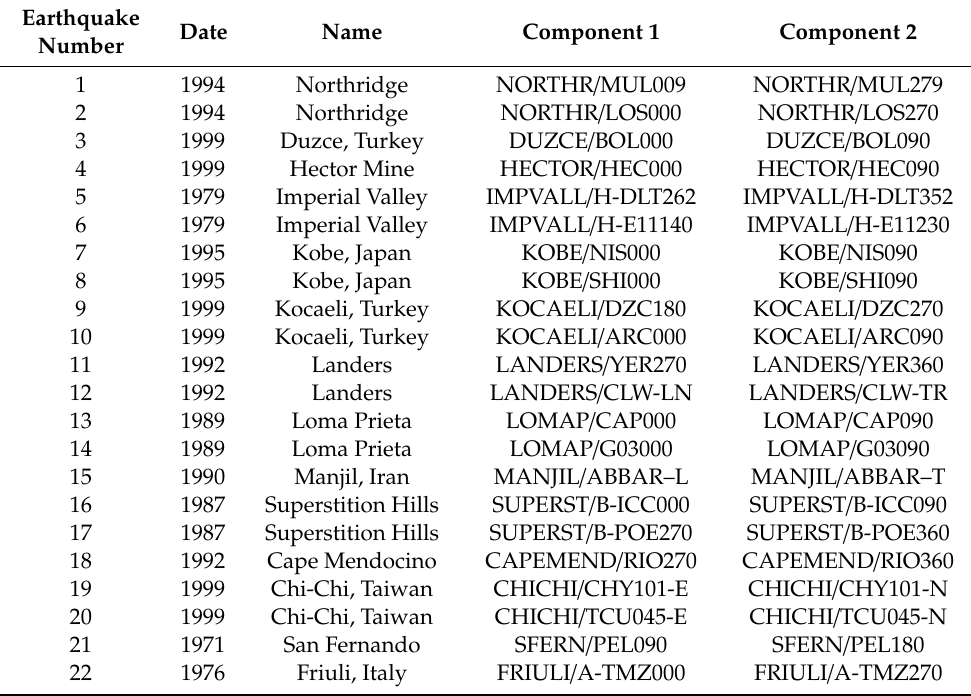
Table 2. FEMA P-695 far-field ground motion records